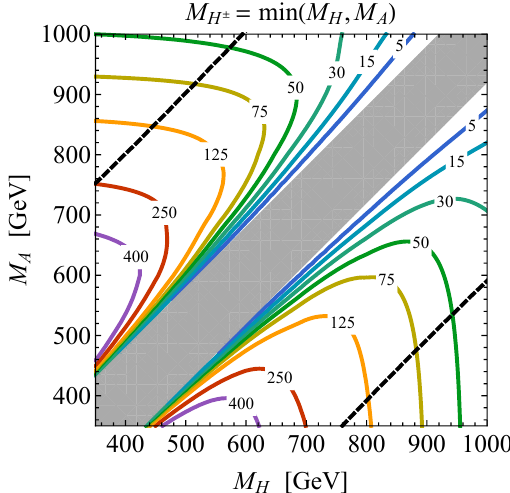
p s = 14 TeV for pp ! tbW production in units of = H (cid:6) =M ) > H (cid:6) H (cid:6)